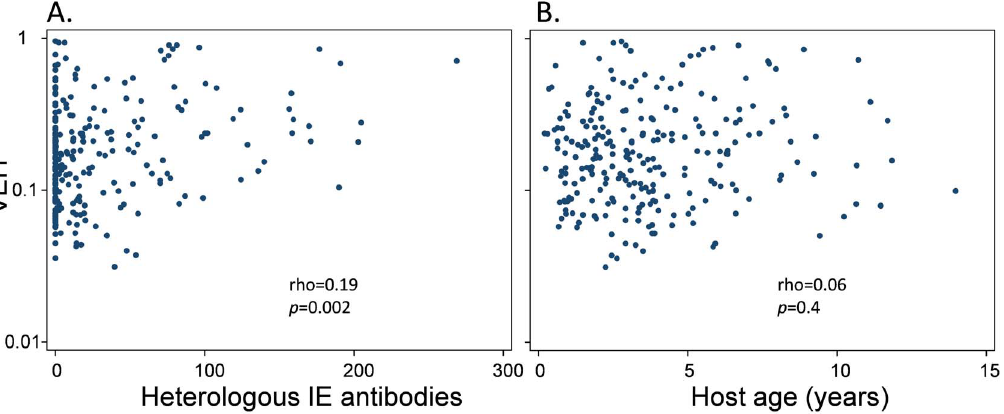
Figure 3. The relationship between VEH and host IE surface antibodies Scatter plots are shown of the relationship between VEH and the breadth of the heterologous IE surface antibody response (A, see legend to figure 2); (B) shows the relationship between VEH and host age. Spearman’s rank correlation coefficient rho was used to test for correlation.